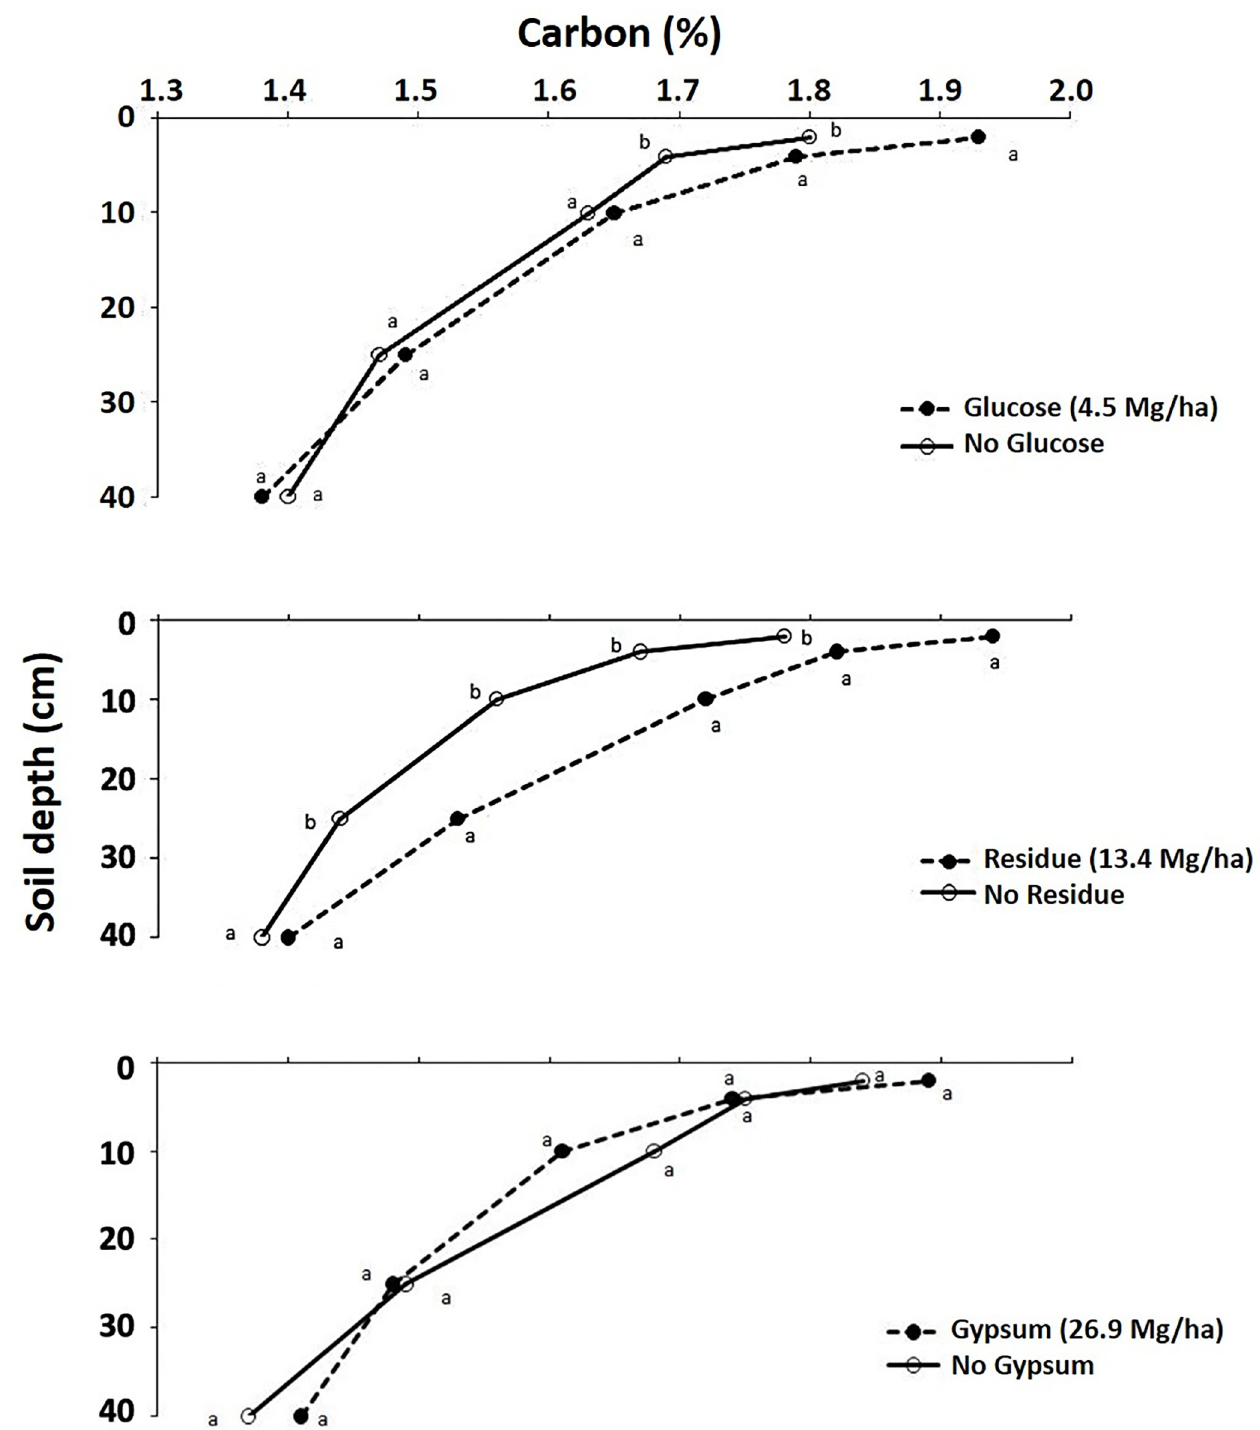
Fig 1. Effect of residue, glucose and gypsum on % carbon concentrations in different soil layers averaged across the Wooster and Hoytville soils. Means with the same letter within the same layer are not statistically different (P < 0.10).